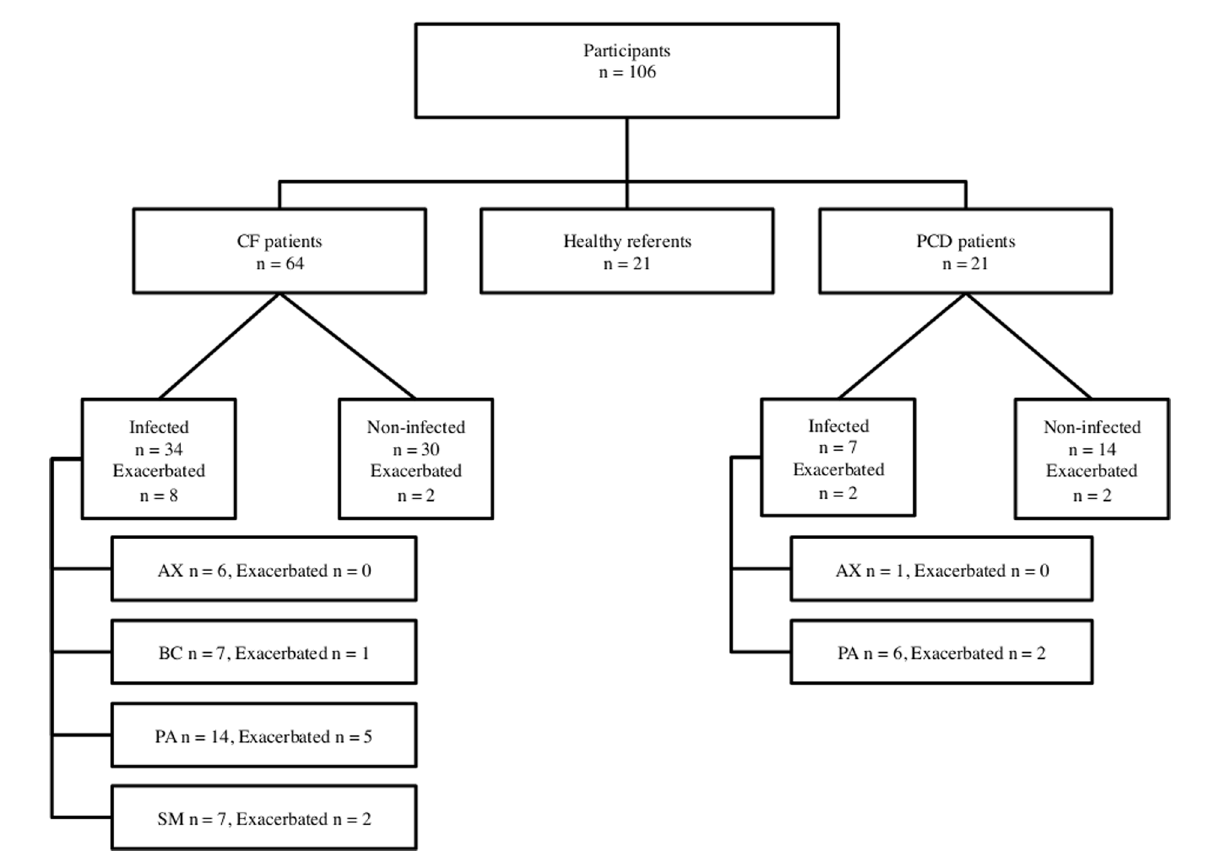
Fig. 1. Flowchart displaying the groups of participants and the subgroups of patients according to chronic infection status and exacerbation status. CF – cystic fibrosis. PCD – primary ciliary dyskinesia. AX – A. xylosoxidans . BC – Burkholderia cepacia complex. PA – P. aeruginosa . SM – S. maltophilia